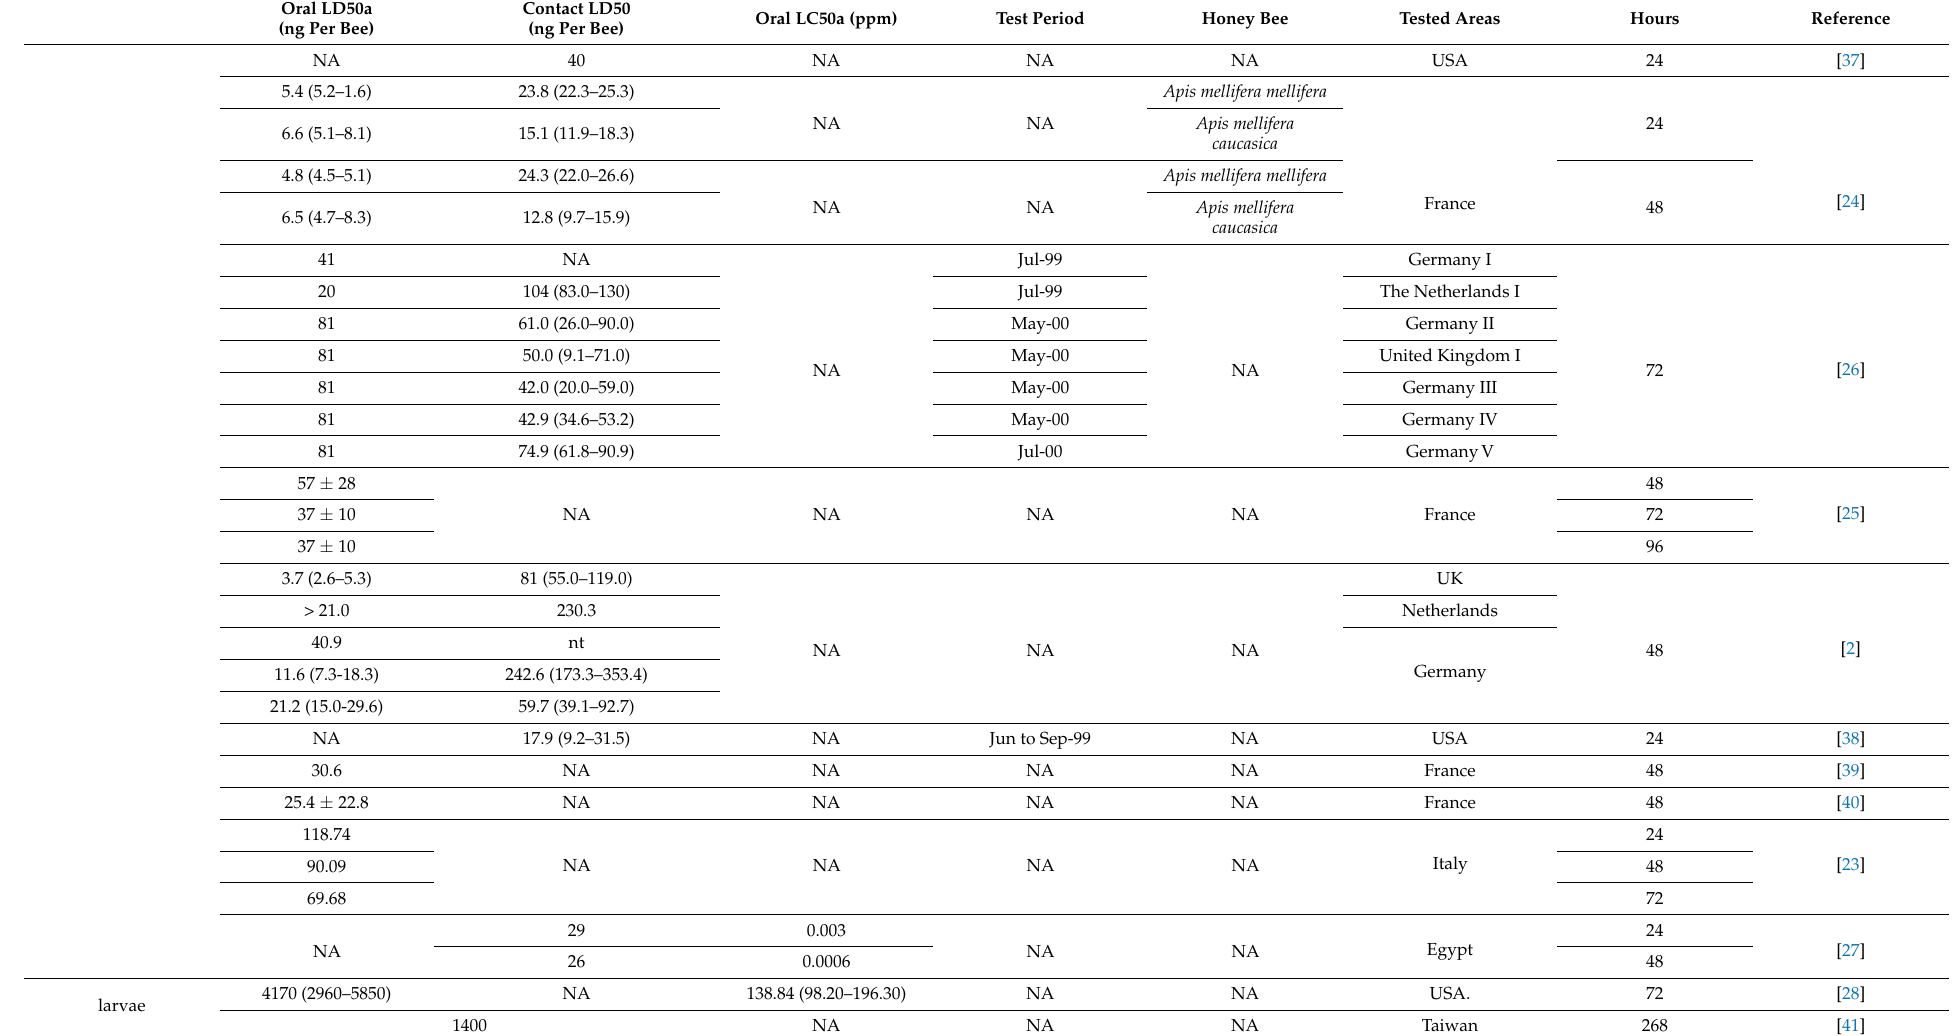
Table 1. LD 50 and LC 50 results for imidacloprid in honey bees (Apis